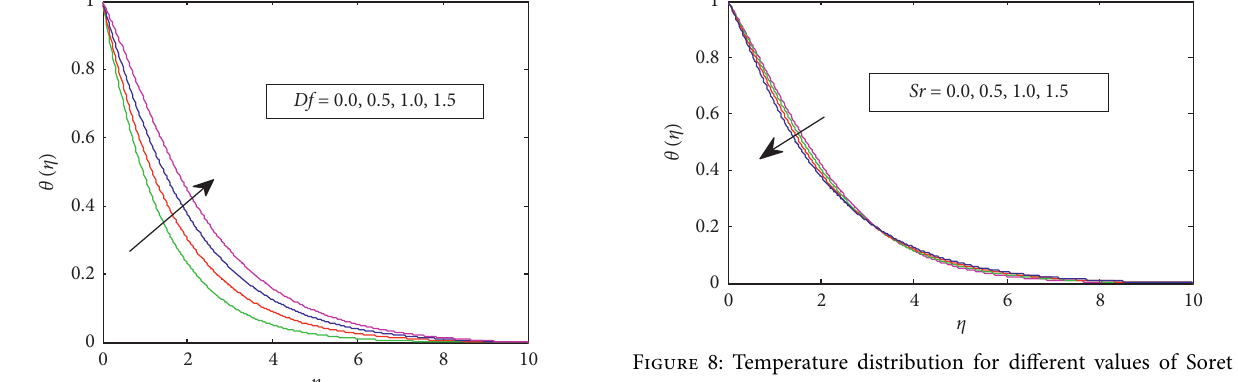
Figure 5: Temperature distribution for different values of Dufour parameter.